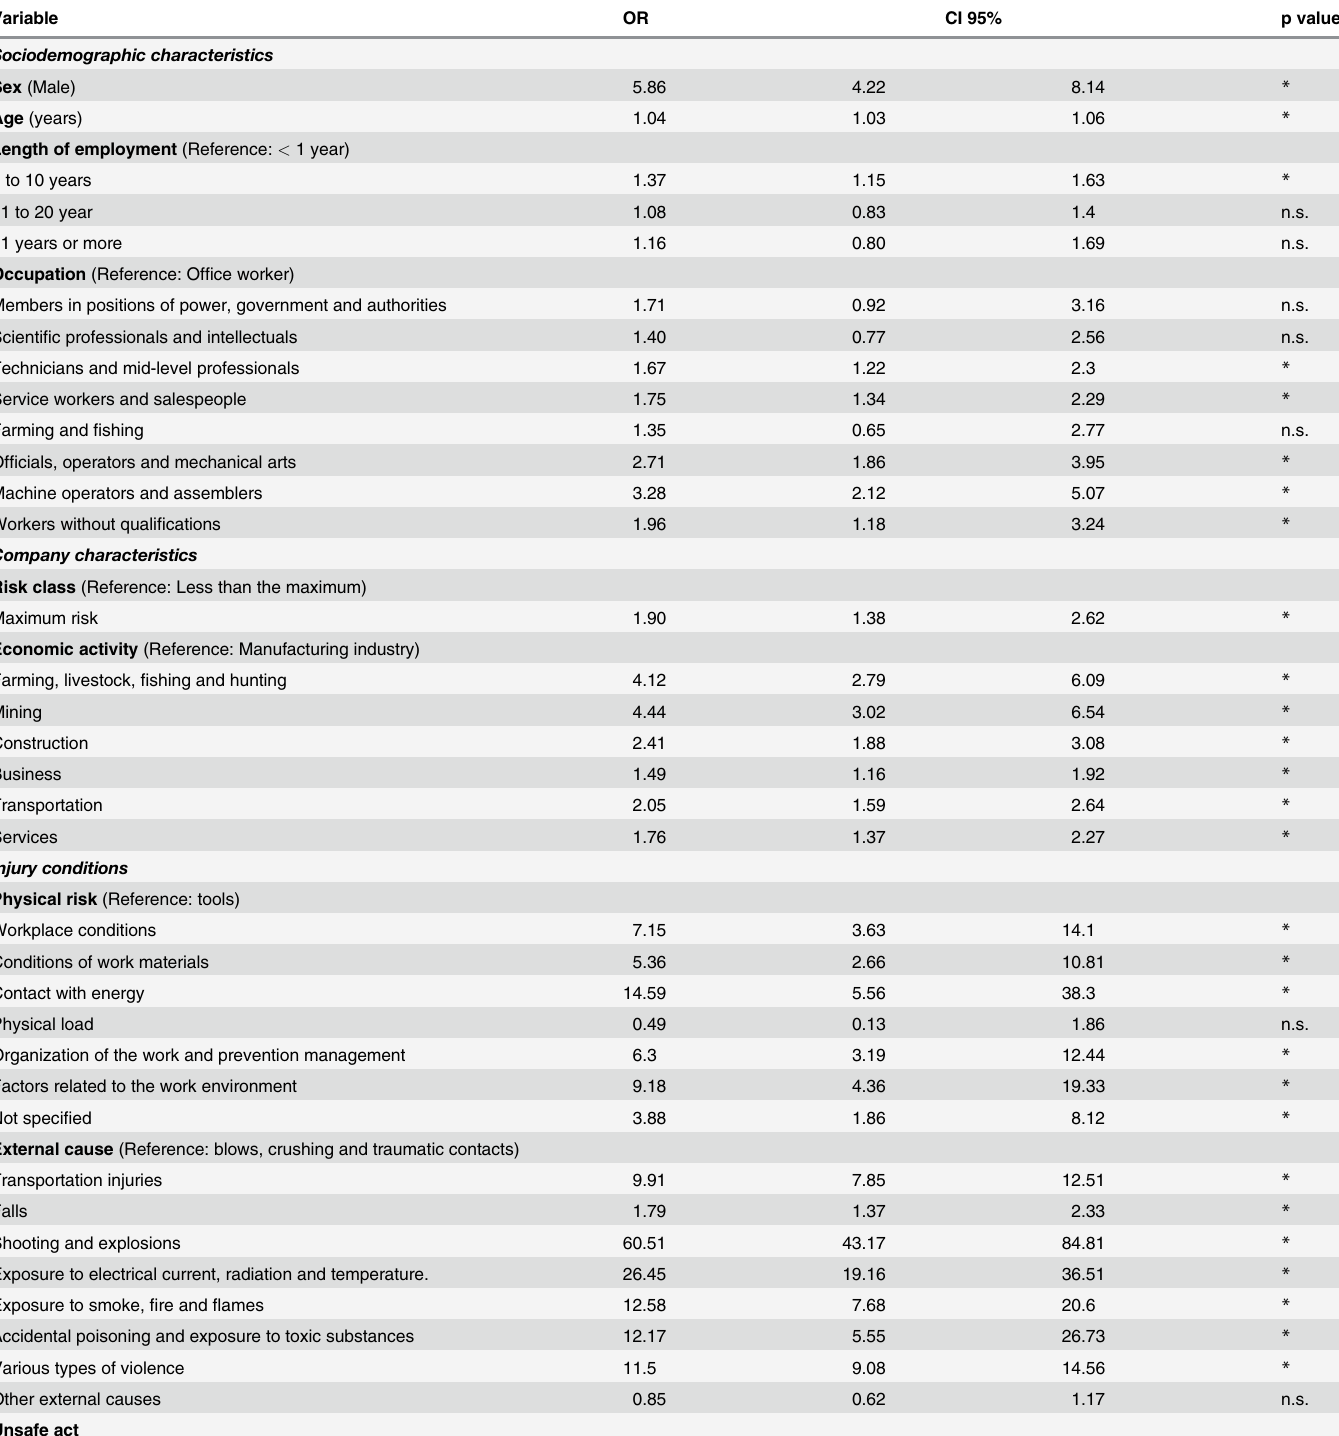
Table 3. Logistic regression model for fatal occupational injuries (deaths) versus non-fatal occupational injuries (with temporary disability and without sequels, or without disability) among workers in the IMSS in 2012.